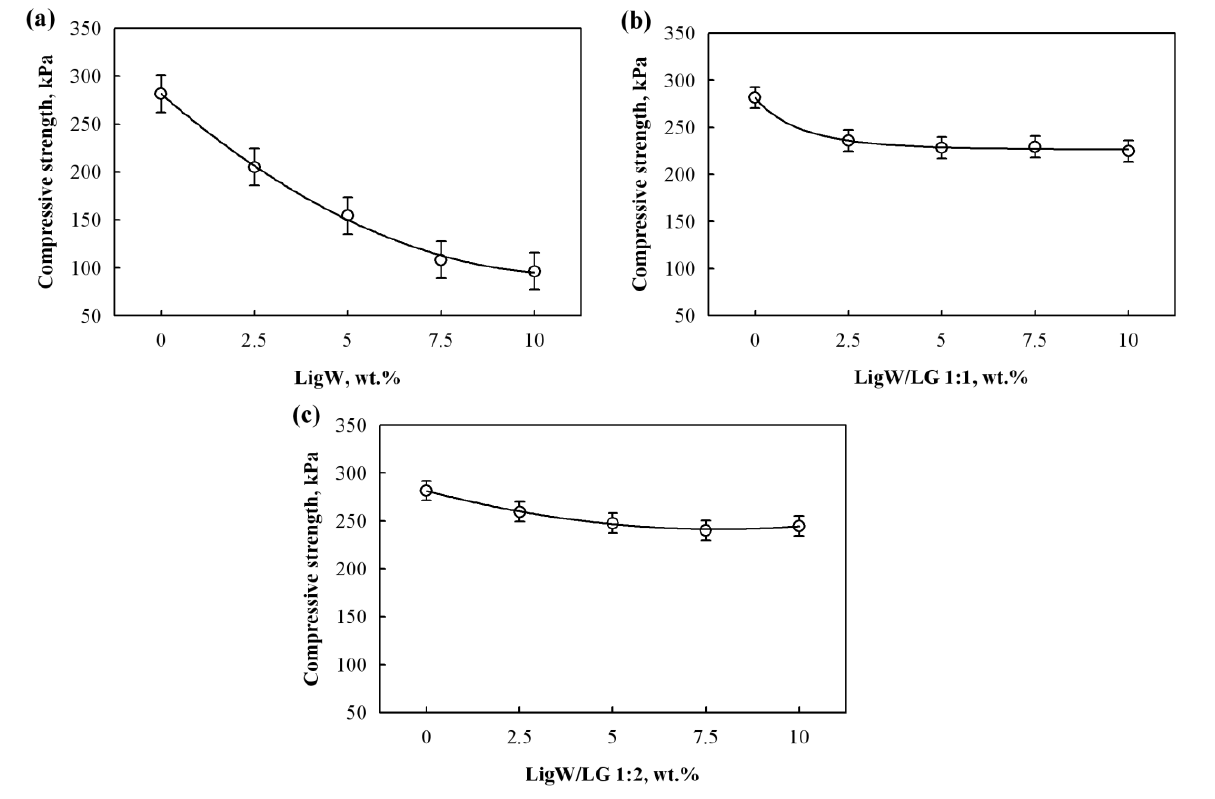
Figure 6. Compressive strength of bioPUR foams with: ( a ) LigW particles; ( b ) LigW/LG 1:1 particles; ( c ) LigW/LG 1:2 particles. ( c ) LigW/LG 1:2